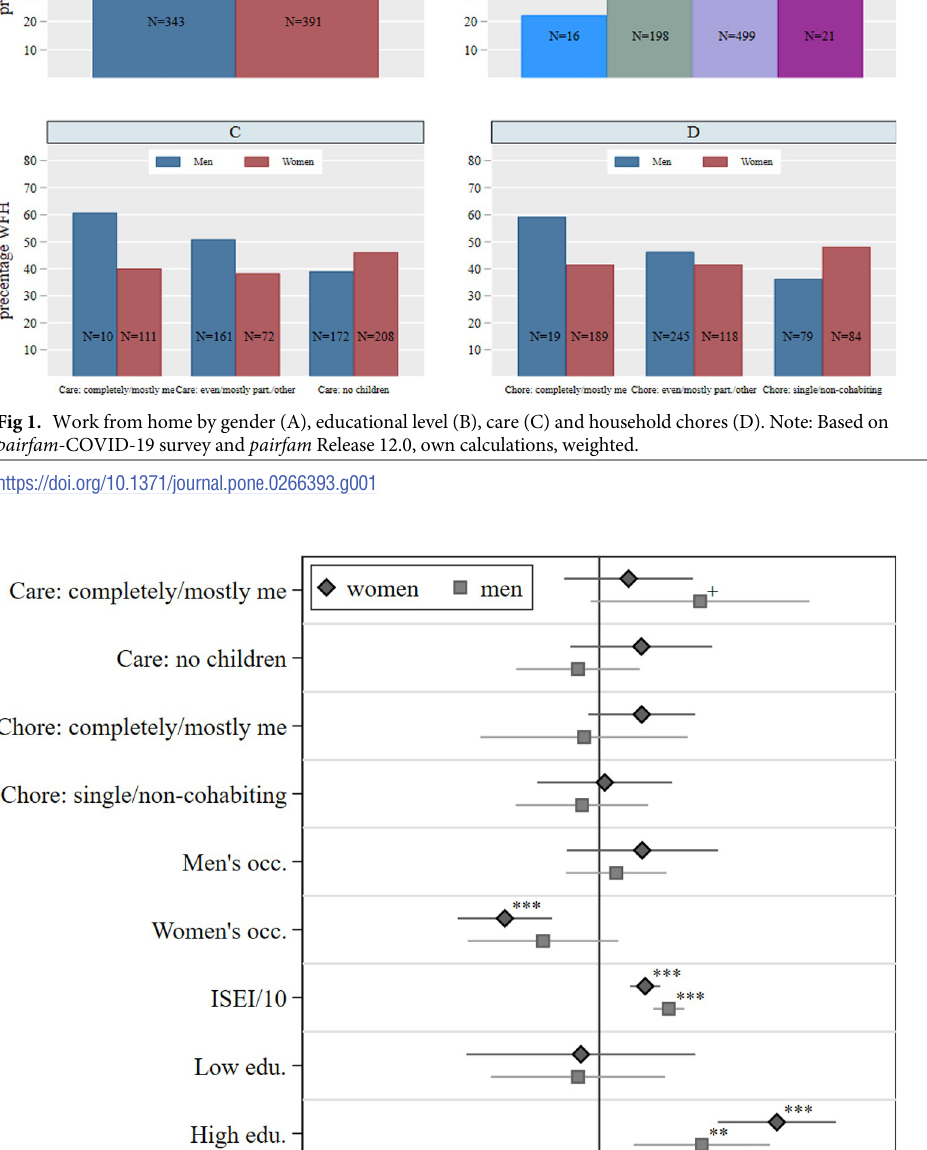
PLOS ONE | https://doi.org/10.1371/journal.pone.0266393 June 13,